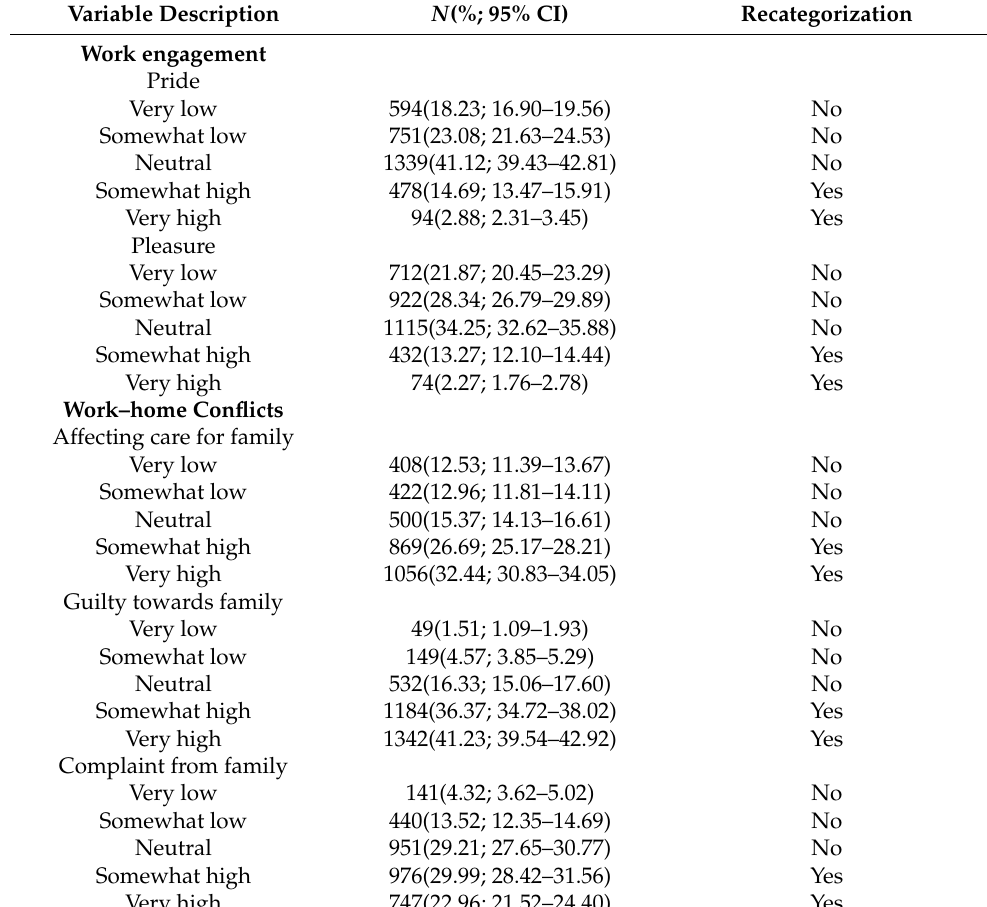
Table 2. Work engagement and work-home conflicts of